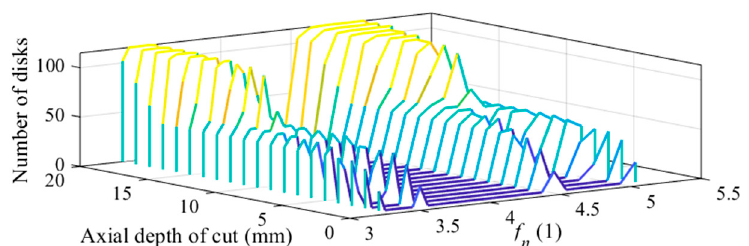
Figure 9. The number of discrete disks and discrete excitation frequencies as a function of the axial depth of cut for the multivariable tool.